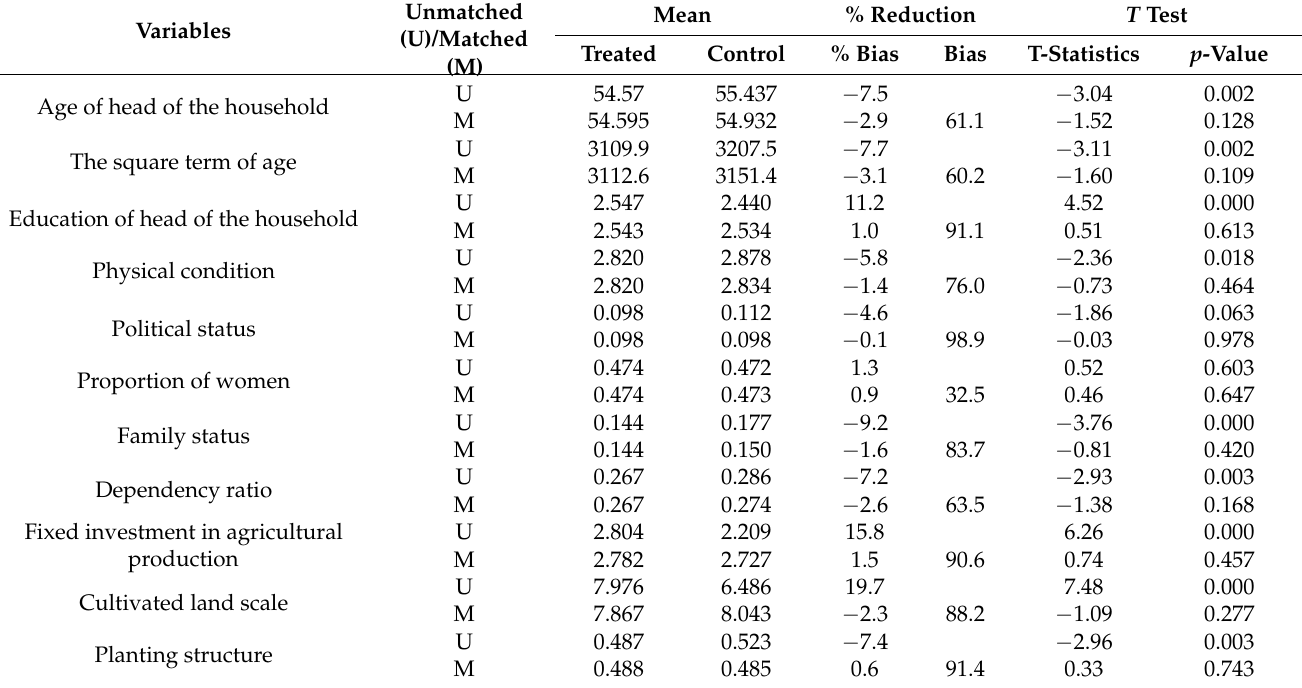
Table 6. Results of balance test.